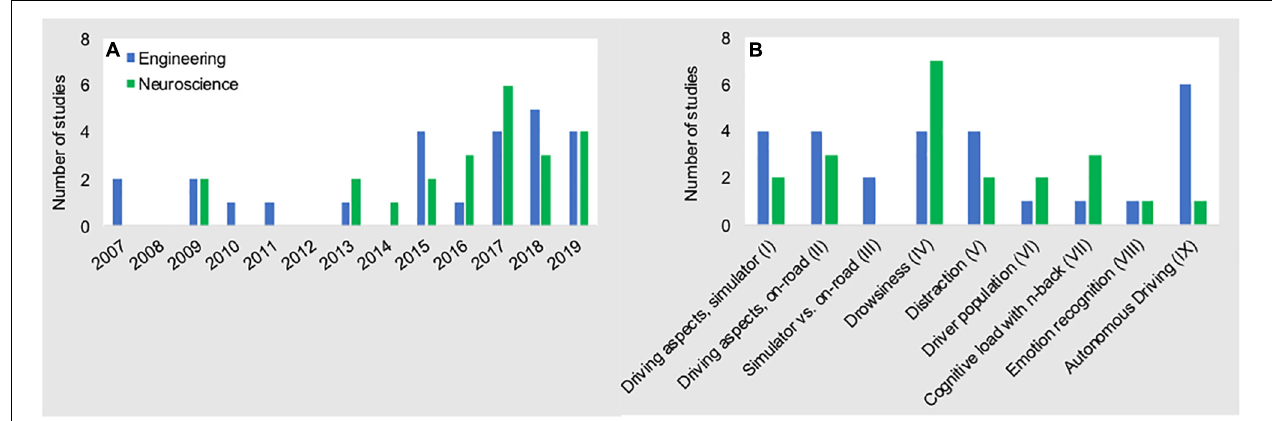
FIGURE 6 | Number of fNIRS driving studies conducted from 2007 to 2019 (A) , and research topics (B) for both disciplines. Data presented here are the data that are presented in Figure 3 above, stratified across disciplines of origin.